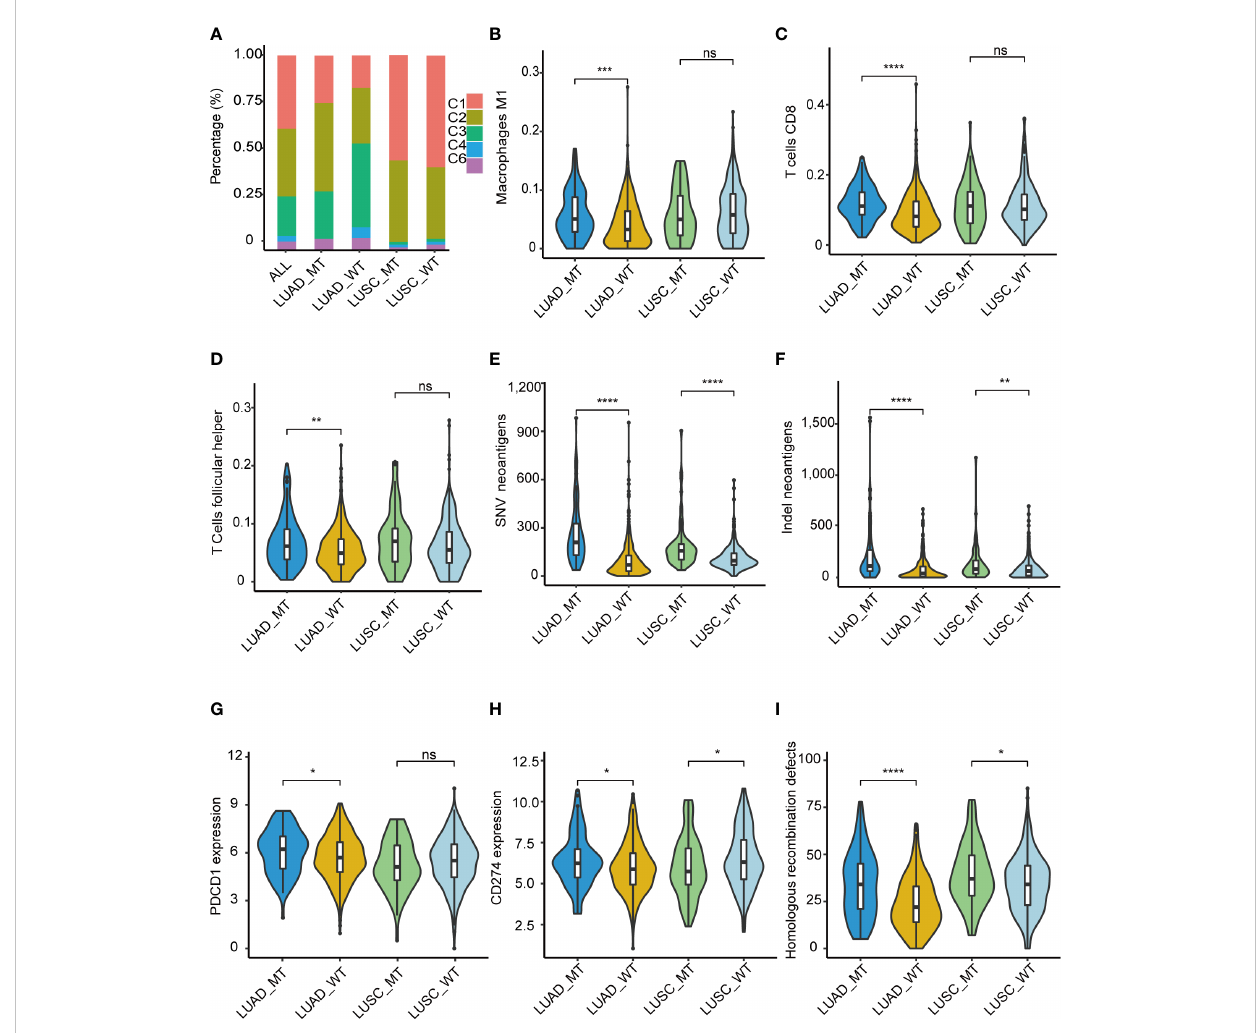
FIGURE 6 Immune-related features of the model in the TCGA cohorts. (A) Distribution difference of fi ve immune subtypes in the TCGA cohorts. (B) M1 macrophage, (C) T.cells.CD8, (D) T.cells.follicular.helper. Comparison analysis of Comparison analysis of TNB among four groups of LUAD_MT, LUAD_WT, LUSC_MT, and LUSC_WT. (E) SNV, (F) InDel. Immune in fi ltration analysis revealed four signi fi cantly different cells according to the RNA gene expression data of TCGA among four groups of LUAD_MT, LUAD_WT, LUSC_MT, and LUSC_WT. (G) PDCD1 (PD-1) gene and (H) CD274 (PD-L1) gene expression among four groups of LUAD_MT, LUAD_WT, LUSC_MT, and LUSC_WT. (I) Comparison analysis of HRD gene signature score among four groups of LUAD_MT, LUAD_WT, LUSC_MT, and LUSC_WT. * P ≤ 0.05; ** P ≤ 0.01; *** P ≤ 0.001; **** P ≤ 0.001; ns, not signi fi cant. LUAD, lung adenocarcinoma; LUSC, lung squamous cell carcinoma; SNV, single nucleotide variant; InDel, insertion-deletion. PDCD1 gene, coding gene of PD-1 protein; CD274 , coding gene of PD-L1 protein; HRD, Homologous recombination